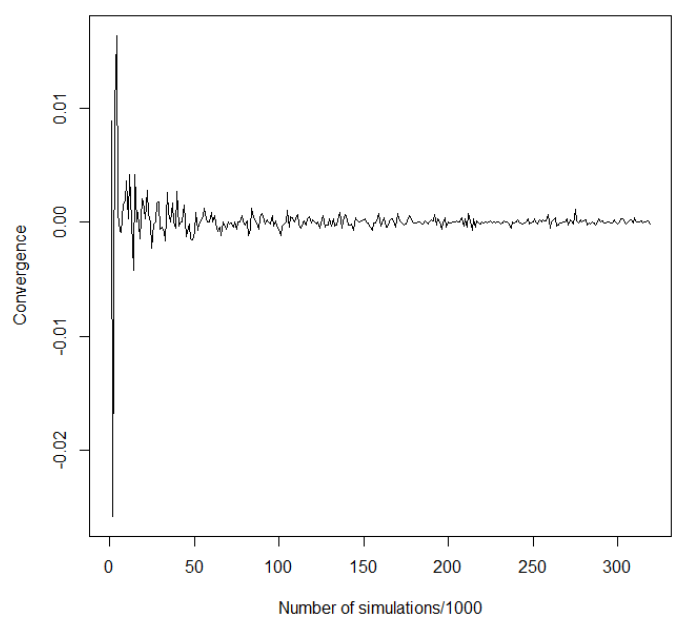
Figure 2. Convergence of quantiles at 0.99.